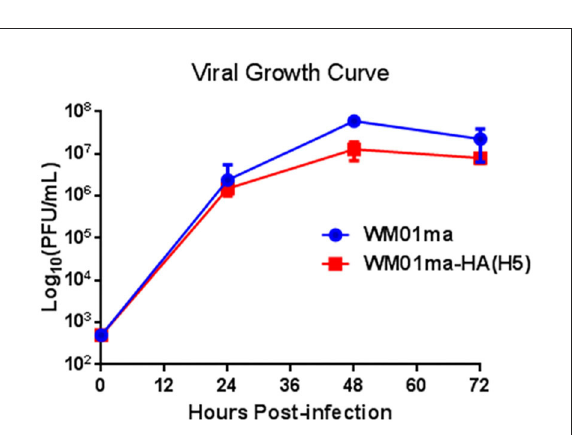
FIGURE5 Growth curve of the recombinant WM01ma-HA (H5) influenza virus on MDCK cells stably expressing NA protein. The viral titers in each time point were calculated in triplicate. The values represent the means ± standard deviations (SD).